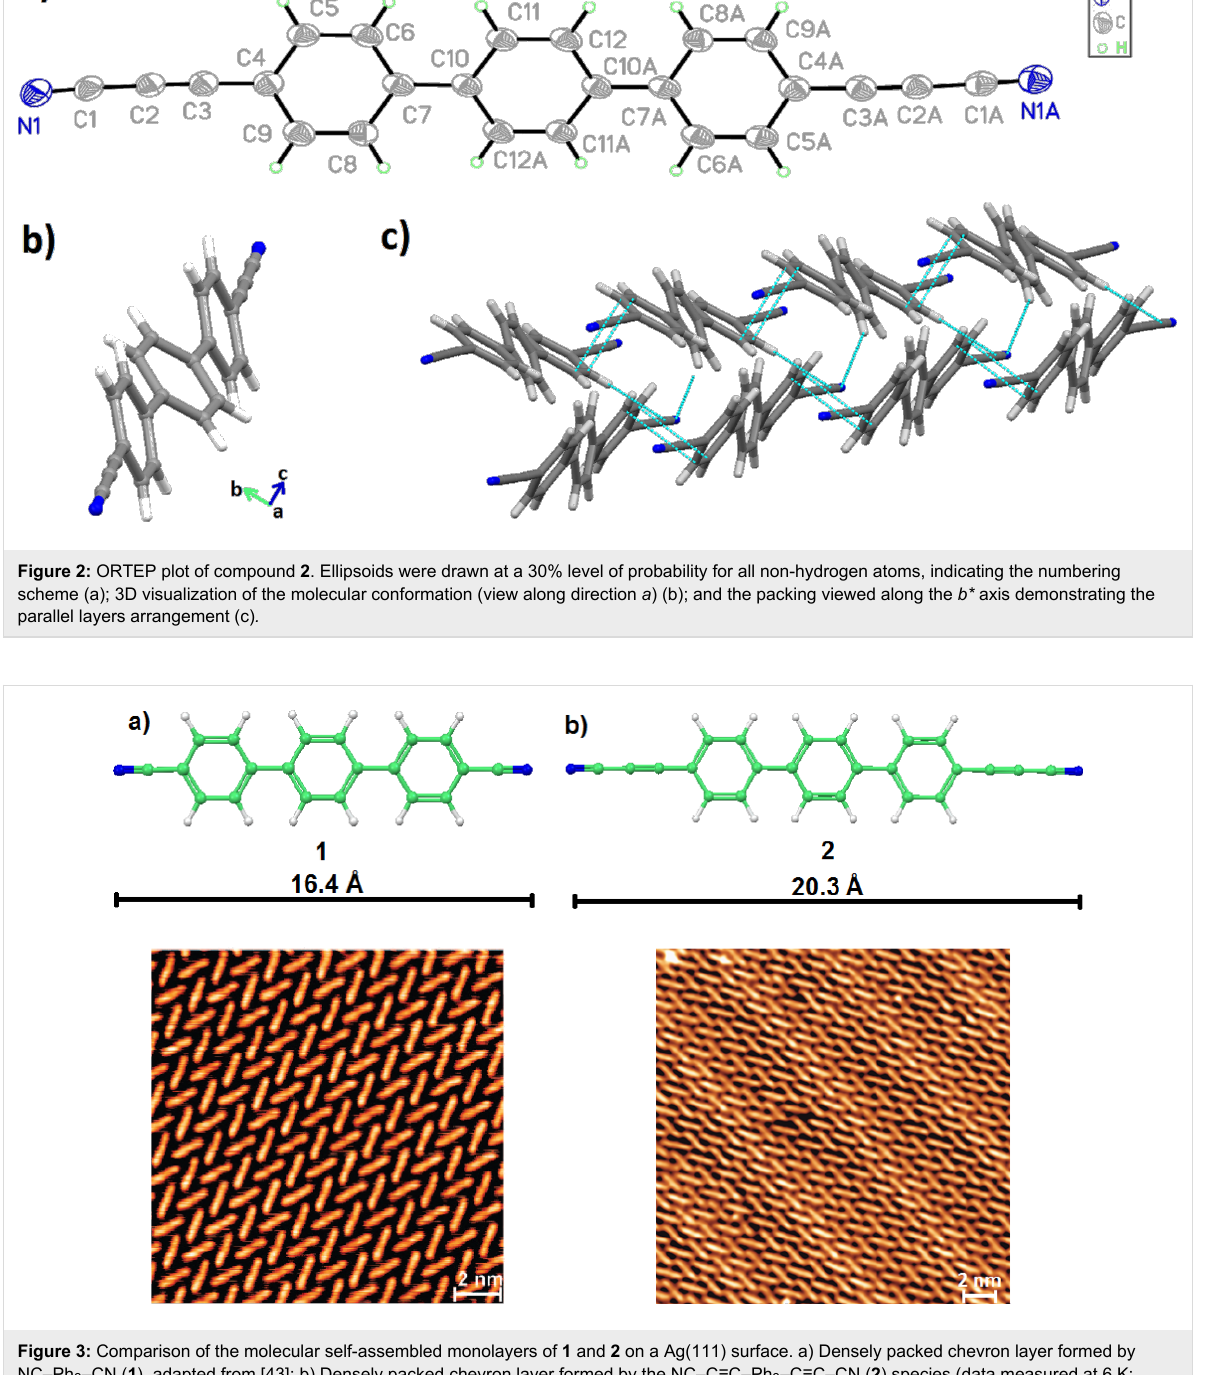
showing the very subtle balance between molecule–substrate and molecule–molecule interactions. Occasionally, deviations from molecular linearity as an S-shape of certain protrusions could be identified. Similar to the earlier observations for dicar-